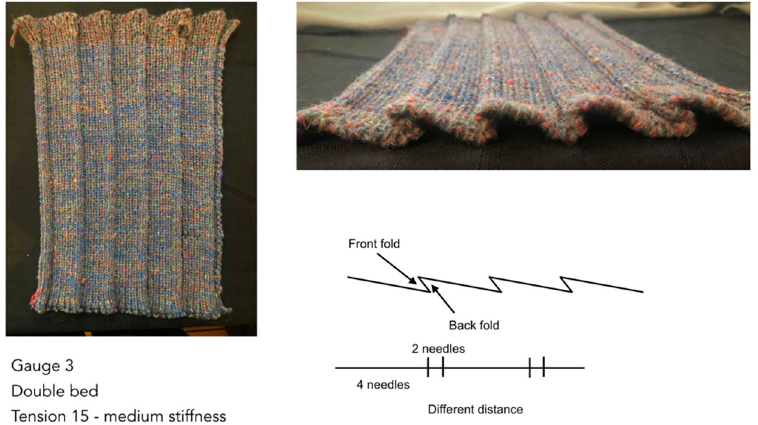
Figure 8. Sample 1. Medium